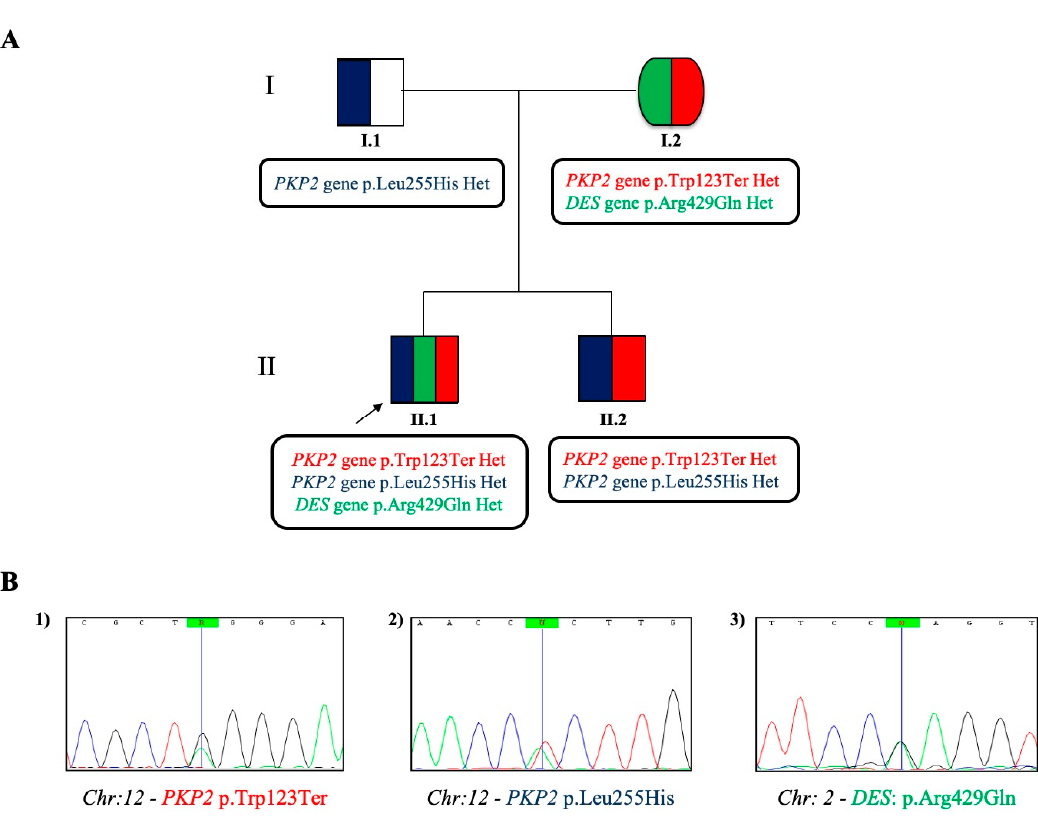
Figure 2. Pedigree of the analyzed family. A ) The pedigree shows the segregation of the variants (in color) detected in the a ff ected boy and his family. In the patient I.1, the variant carried in the heterozygous status is the novel c.764T > A (p.Leu255His) in the Plakophilin ( PKP2 ) gene; I.2 carried two di ff erent variants: one in the PKP2 gene (the c.368G > A (p.Trp123Ter)) and the other (found with next-generation sequencing (NGS) technology) in the DES gene (the c.1286G > A (p.Arg429Gln)), both in heterozygosity. The proband of the study (II.1) shows all the three variants cited above in the parents; his younger brother (II.2) shows only the two variants in the PKP2 gene. B ) Electropherograms from Sanger Sequencing for 1) PKP2 : c.368G > A, 2) PKP2 : c.764T > A, and 3) DES : c.1286G > A variants, respectively.